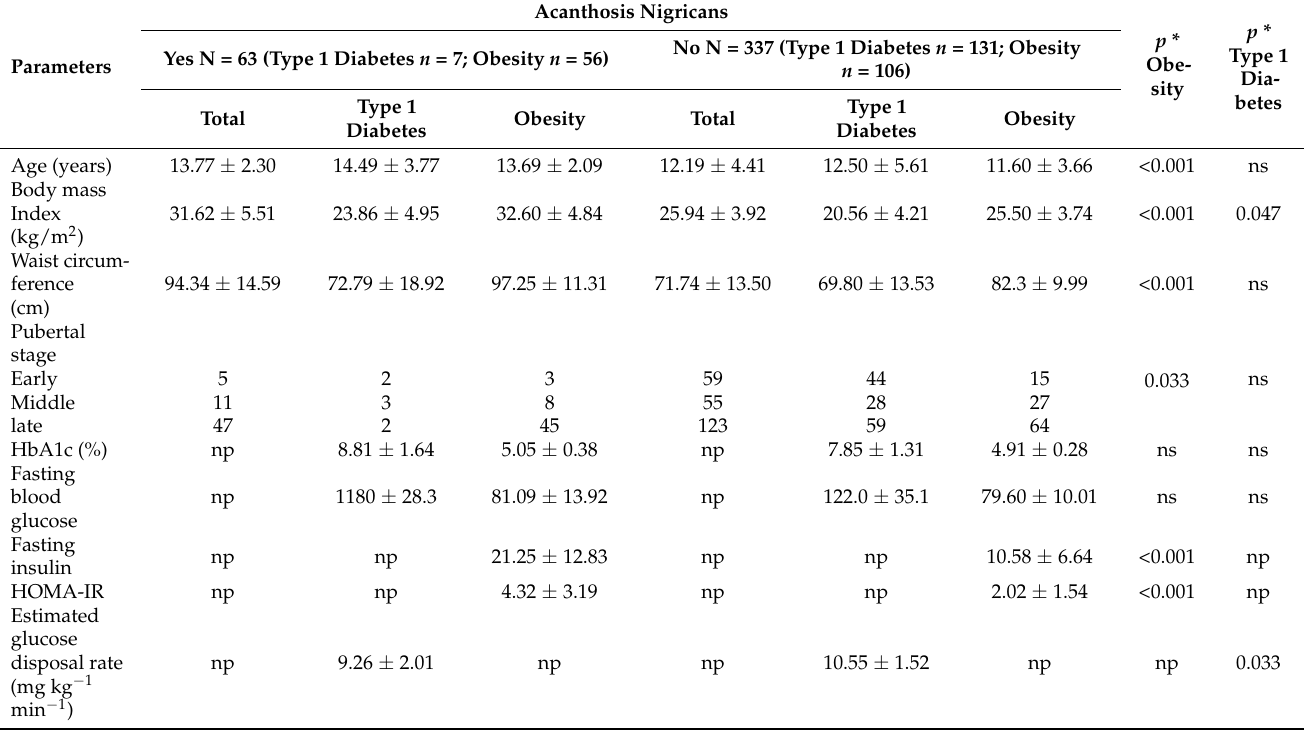
Table 2. Clinical and biochemical features of the patients with or without acanthosis